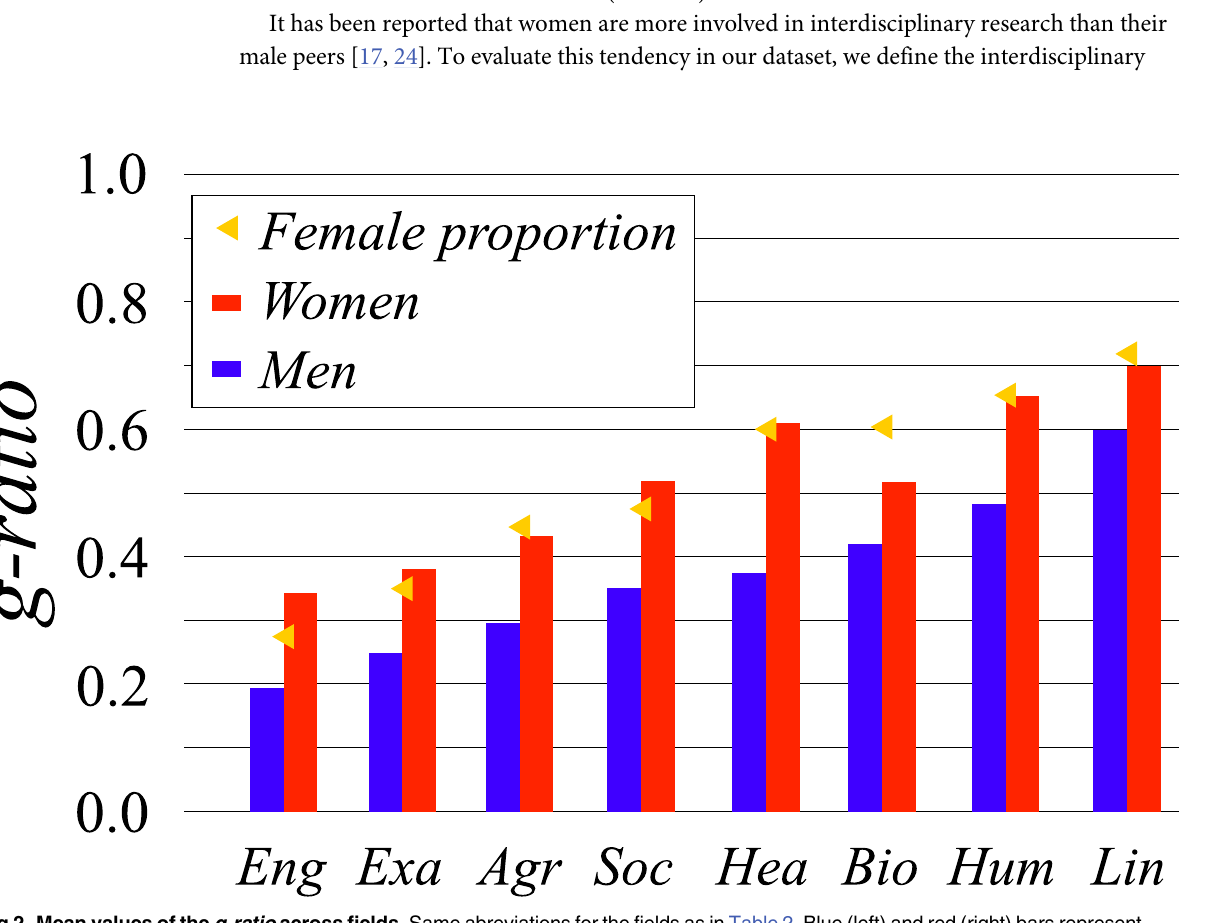
Fig 2. Mean values of the g-ratio across fields. Same abreviationsfor the fields as in Table 2. Blue (left) and red (right) bars represent values for men and women, respectively. Yellow trianglesshow the fraction of women workingin the respectivefield. The error bars are smaller than 0.1% (see Table